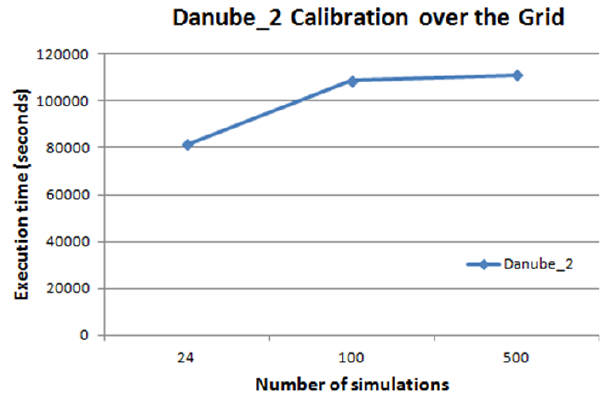
Fig. 11. Danube 2 total calibration time over the grid.